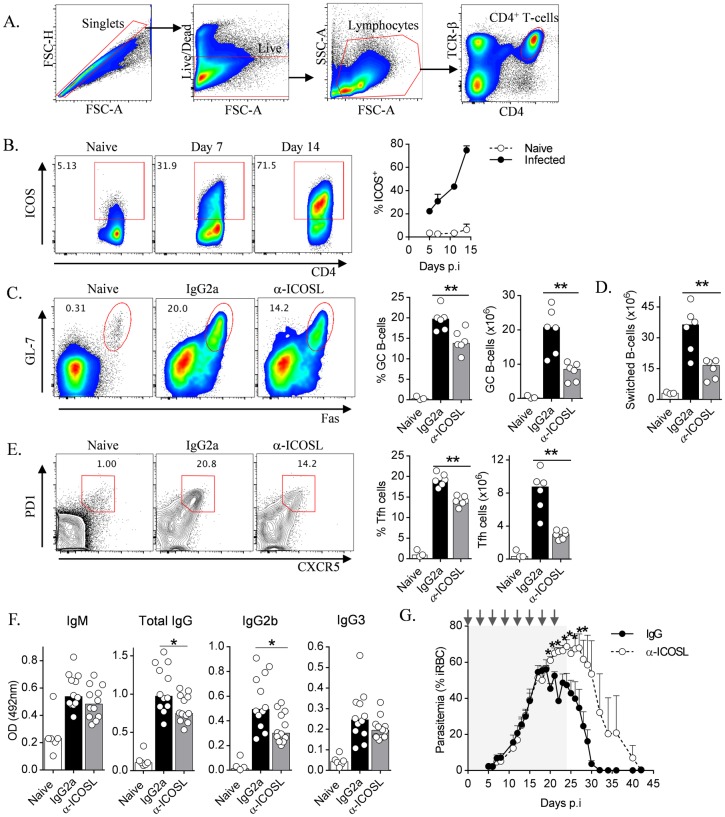
ICOS-signalling promotes humoral immune responses during blood-stage infection.(A) Flow cytometric gating strategy employed to analyze splenic CD4+ T-cell responses throughout the manuscript. (B) Representative FACS plots and time-course analysis of cell-surface ICOS expression on splenic CD4+ T-cells from WT mice (n = 3/time point) during Py17XNL infection. (C-F) WT mice (n = 6/group) were treated with anti-ICOSL blocking monoclonal antibody (α-ICOSL) or its isotype control (rat-IgG2a) prior to and during infection with Py17XNL. (C) Representative FACS plots (gated on B220+ CD19+ live singlets), proportions and numbers of splenic GC B-cells (GL-7+ Fas+), (D) numbers of splenic Ig-class switched (IgDlo IgMlo) B-cells, and (E) representative FACS plots (gated on CD4+ TCRβ+ live singlets), proportions and numbers of splenic Tfh cells (PD1+ CXCR5+), in naïve mice and infected, α-ICOSL and control IgG-treated mice, 16 days p.i. (F) Py17XNL-specific IgM, total IgG, IgG2b and IgG3 levels in serum of naïve and infected, α-ICOSL and control IgG-treated mice, 16 days p.i. (G) Parasitemias in WT mice (n = 6/group) infected with Py17XNL, and treated every three days with α-ICOSL or control IgG until day 21 p.i. (depicted by arrows, with estimated period of cover highlighted with shaded grey box—an α-ICOSL-treated mouse succumbed to infection on each of days 15, 17 and 30 p.i., and one control-IgG treated mouse succumbed on day 20 p.i. Data representative of two independent experiments in (B-E), and two pooled independent experiments in (F), with experiment in (G) being conducted once. Statistics: Mann-Whitney U test, *P<0.05; **P<0.01.